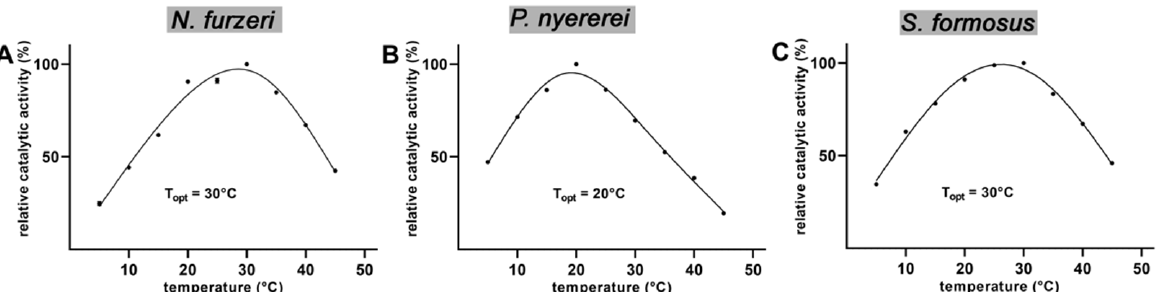
Figure 4. Temperature dependence of ALOX activity of the randomly selected bony fish ALOX isoforms. Activity assays were carried out using the cellular lysate supernatants as enzymes source. Aliquots of the lysate supernatants were incubated in the standard activity assays with AA as substrate at different temperatures and the amounts of specific ALOX products formed during a 3 min incubation period were quantified by RP-HPLC (see Section 4). At each temperature two independent incubations were carried out. Means and error bars are shown, and curves were calculated by non-linear regression ( A ) N. furzeri , ( B ) P. nyererei, ( C ) S. formosus .